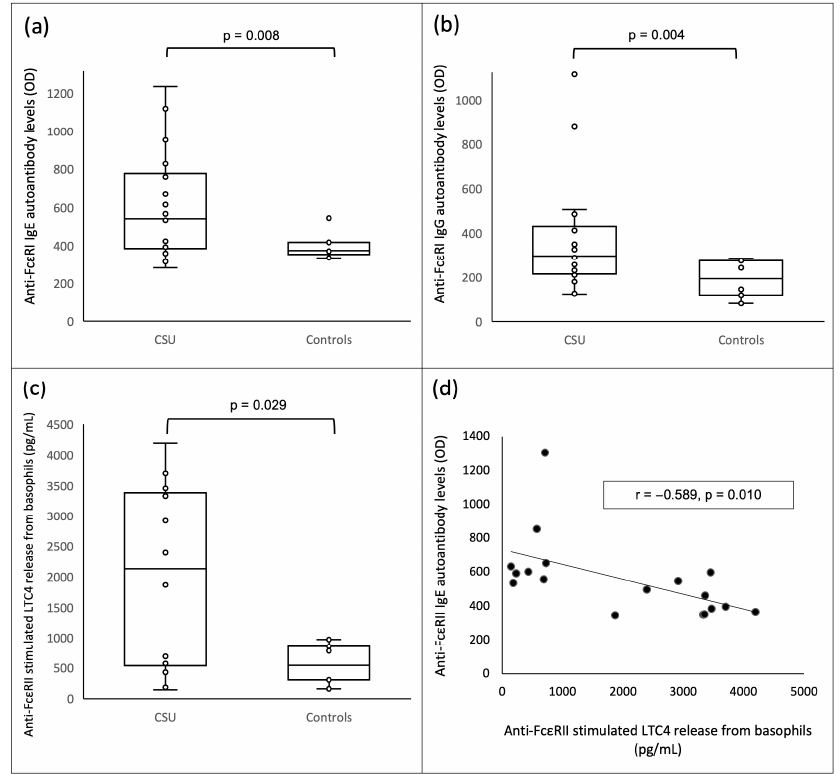
Figure 1. Box plots of anti-Fc ε RI IgE autoantibody levels: ( a ) anti-Fc ε RI IgG autoantibody levels, and ( b ) anti-Fc ε RII stimulated LTC4 release from basophils, ( c ) in patients with chronic spontaneous urticaria and in healthy non-atopic controls. ( d ) scatter plot showing inverse correlation between anti-Fc ε RII IgE autoantibody levels and anti-Fc ε RII stimulated LTC4 release. CSU = chronic spontaneous urticaria; OD = optical density.